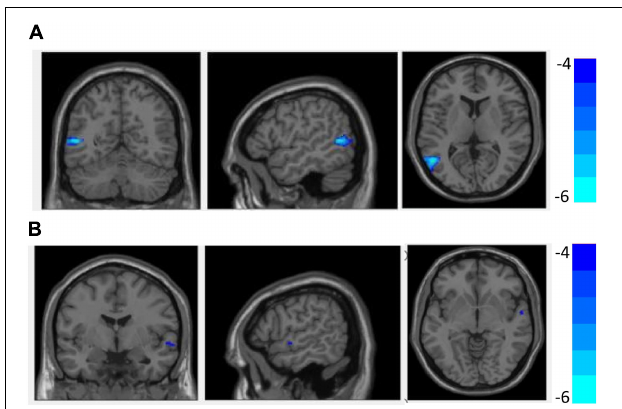
FIGURE 1 | Compared with healthy controls (HCs), grey matter volume (GMV) was decreased in the left middle temporal gyrus (A) and right middle temporal gyrus (B) in early-onset schizophrenia (EOS) group ( p < 0.05, FDR